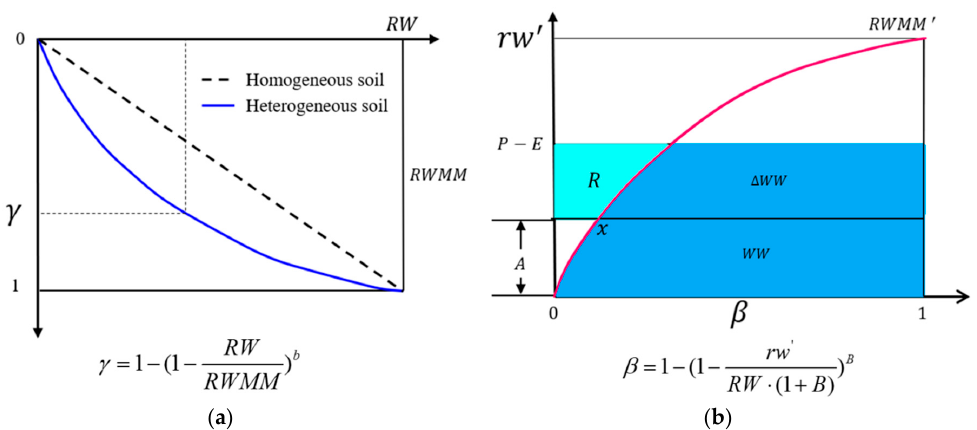
Figure 2. ( a ) The vertical distribution curve of relative soil water storage capacity ( RW ) and ( b ) the spatial distribution curve of relative soil water storage capacity. Note: rw (cid:48) is the relative soil water storage capacity at a point of basin, P − E is net rainfall, A is the value of the ordinate corresponding to WW , and β represents the proportion of the area of the basin, the relative soil water storage capacity of which does not exceed the value of the ordinate rw (cid:48) .